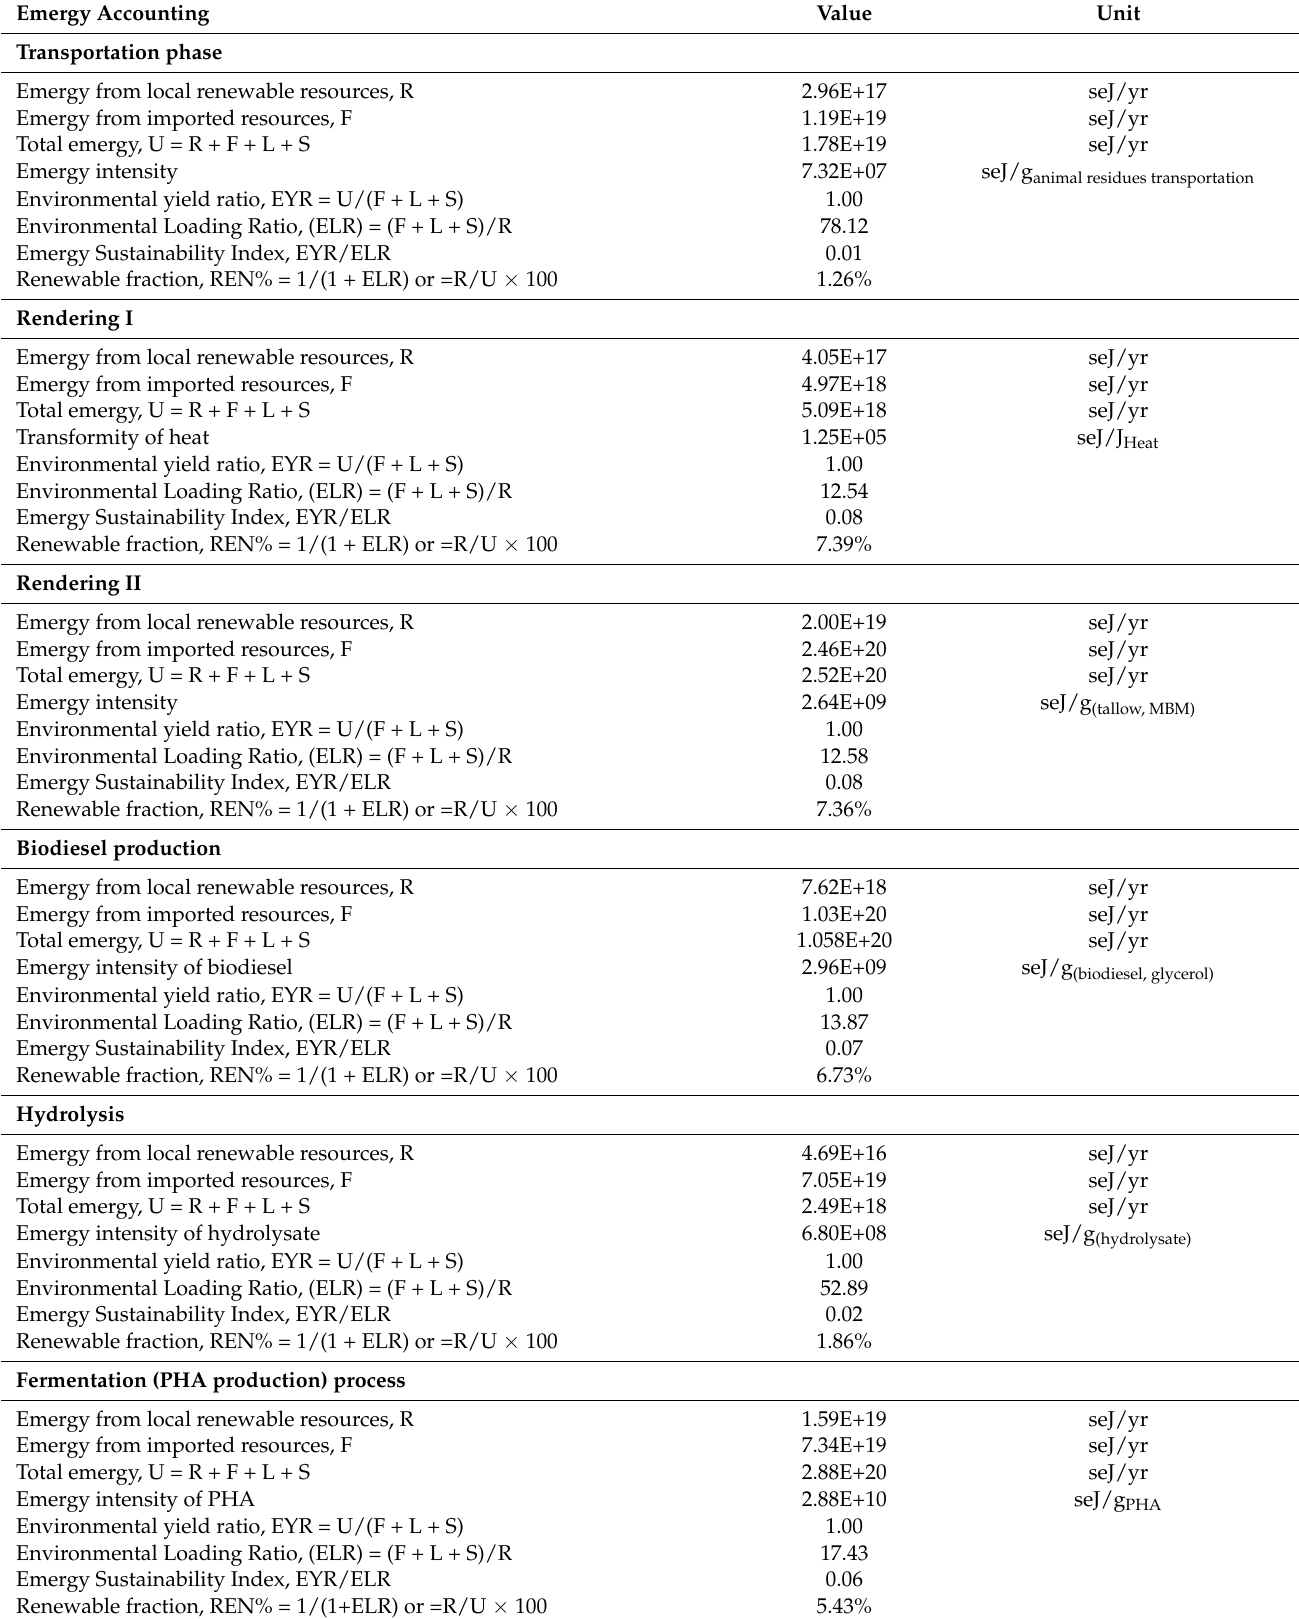
Table 8. Emergy-based indicators calculated for the biobased PHA production overall